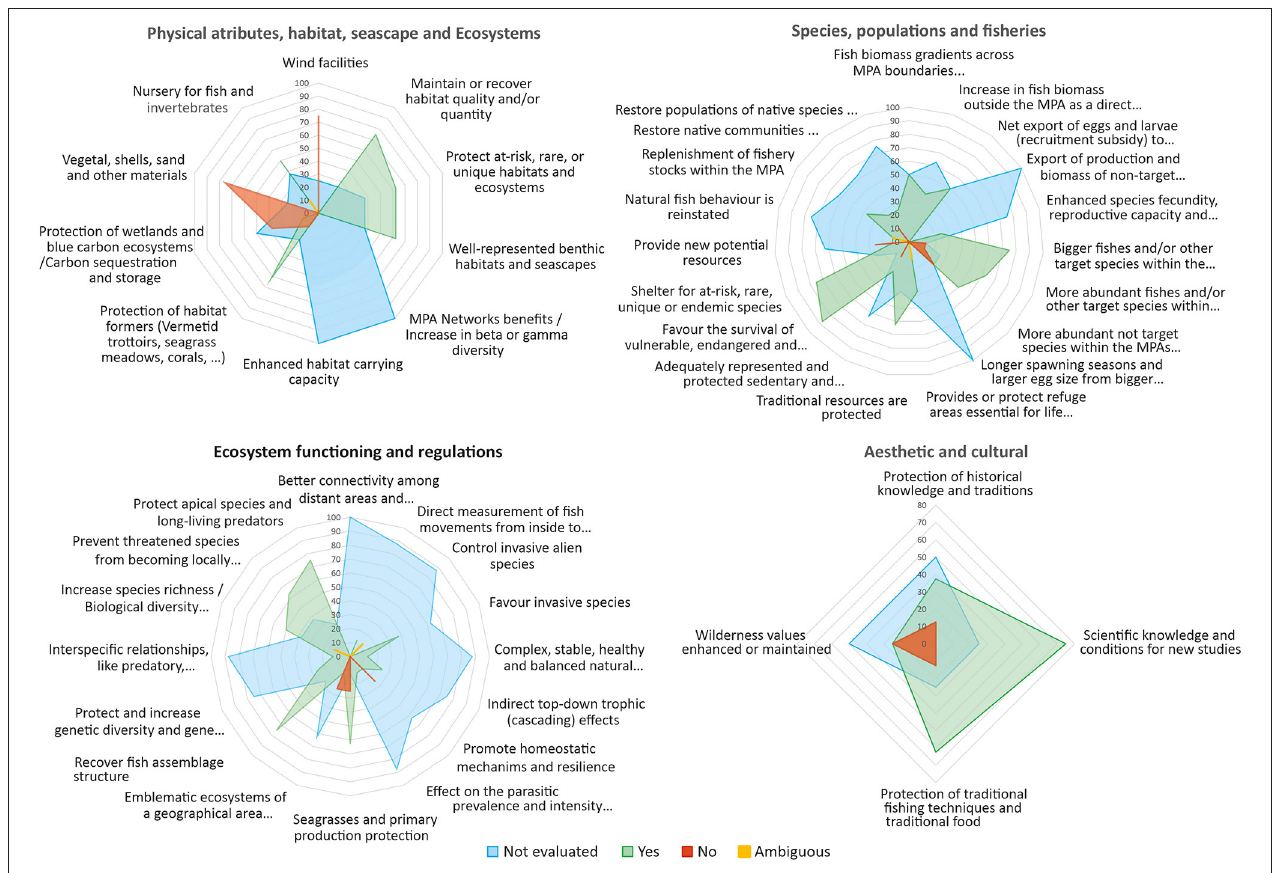
FIGURE 6 | Frequency of occurrence (%) of main Ecosystem services and societal benefits provided by eight of the main Western Mediterranean MPAs included in RESERVEBENEFIT project (see Table 2